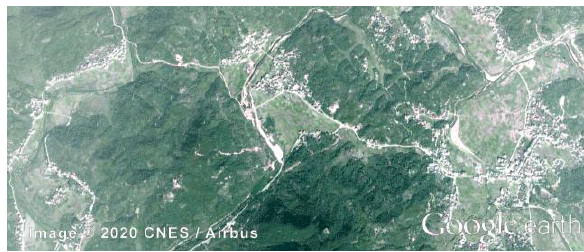
Figure 1. Satellite view of Zhangyang Village in 2019. Elaboration from Google Earth by the first author.